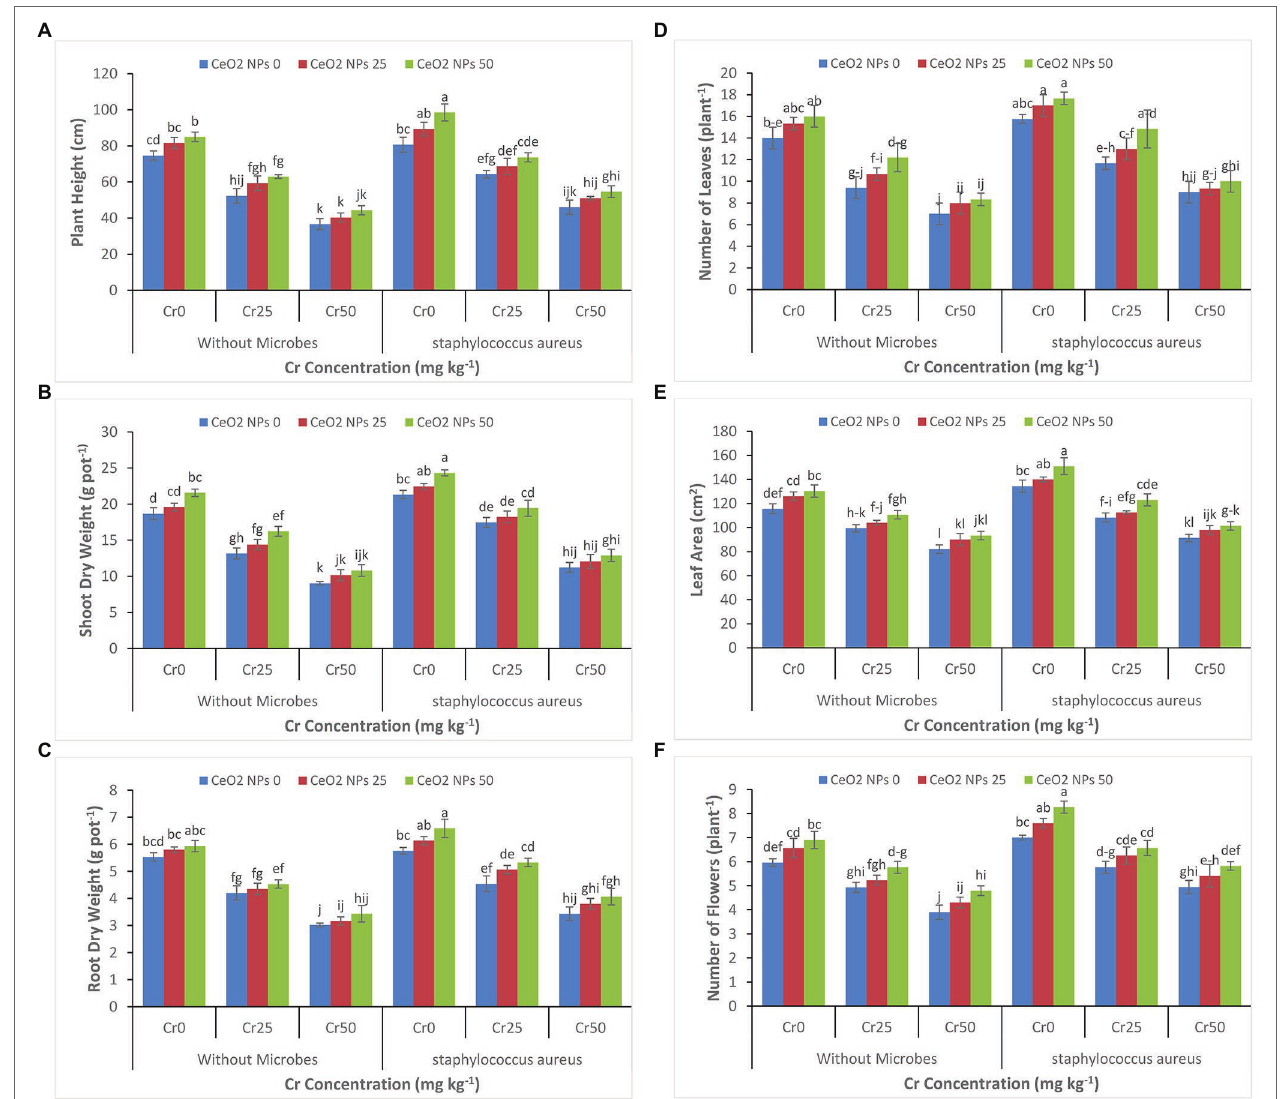
FIGURE 1 | (A–F) : Effect of CeO 2 NPs and Staphylococcus aureus on plant height (A) , shoot dry weight (B) , root dry weight (C) , number of leaves (D) , leaf area (E) , and number of flowers (F) in sunflower plant under Cr stress. The given values are means of three replications with standard deviation. The alphabets represent the significant/non-significant difference at p ≤